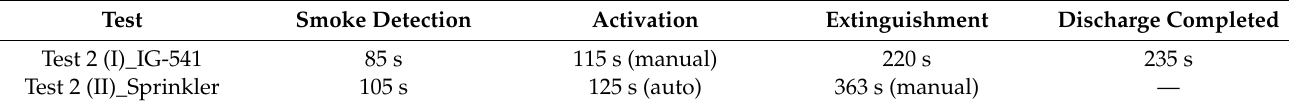
Table 4. The procedures of Test